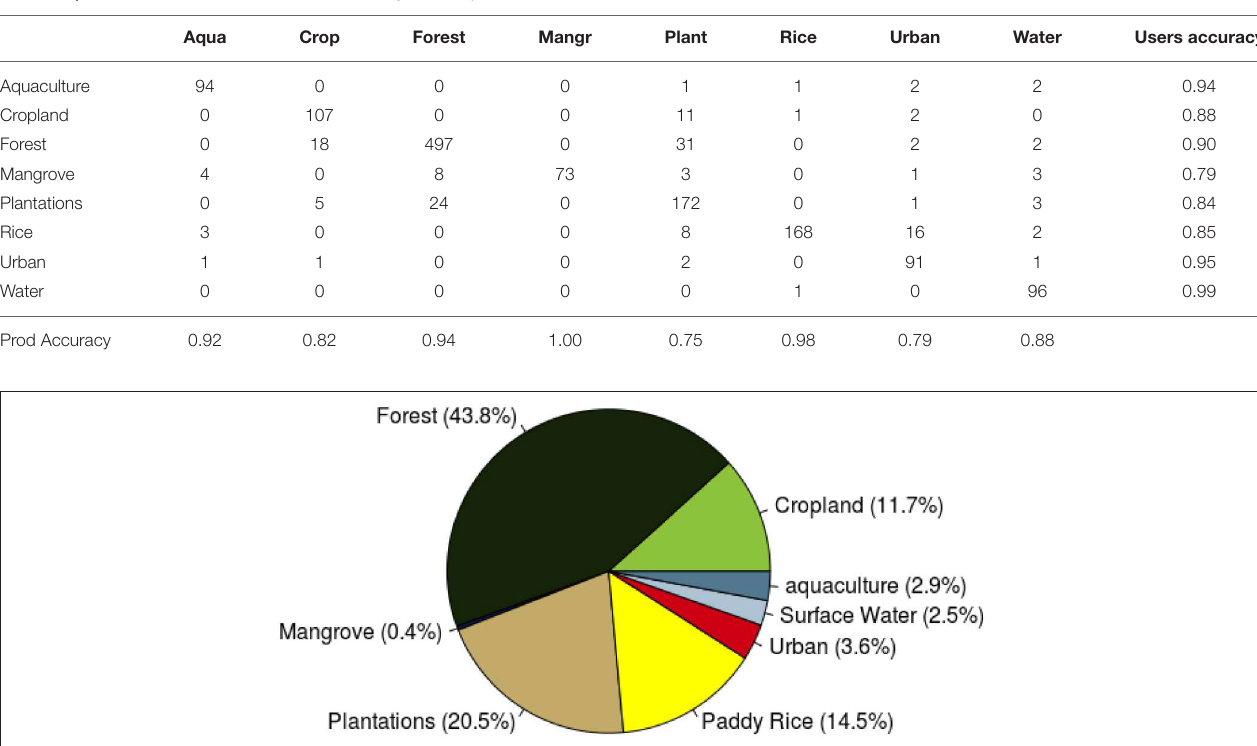
TABLE 3 | Confusion matrix from the Vietnam country level map validation.